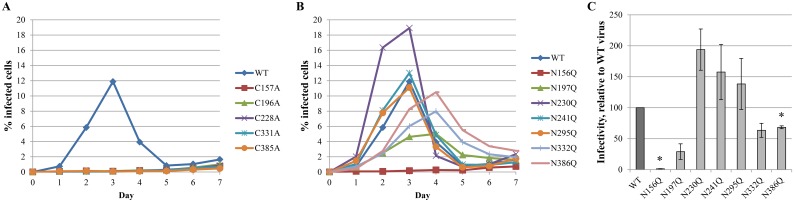
Infectivity of WT and mutant gp120 HIV-1 strains.At day 0, CD4+ T lymphocyte C8166 cells were infected with similar viral loads of WT or mutant virus strains, based on equal amounts of the p24 capsid protein. For 7 consecutive days, samples were harvested, fixed and subjected to flow cytometry to analyse eGFP expression. (A) Infectivity of mutant viruses lacking disulphide bridges in gp120, due to the mutation of one of the involved cysteines into an alanine. (B) Infectivity of mutant viruses lacking one N-glycosylation site in gp120 due to the mutation of the asparagine of the glycosylation motif into a glutamine. (C) The infectivity as shown in panel B was quantified using a linear regression to part of the curves, from day 1 post infection to the peak of the infectivity curve. Data are the means ± SEM of at least 2 independent experiments. The difference between WT and mutant virus was considered to be significant when the p value calculated using the student’s t-test was <0.05 (* = p<0.05).